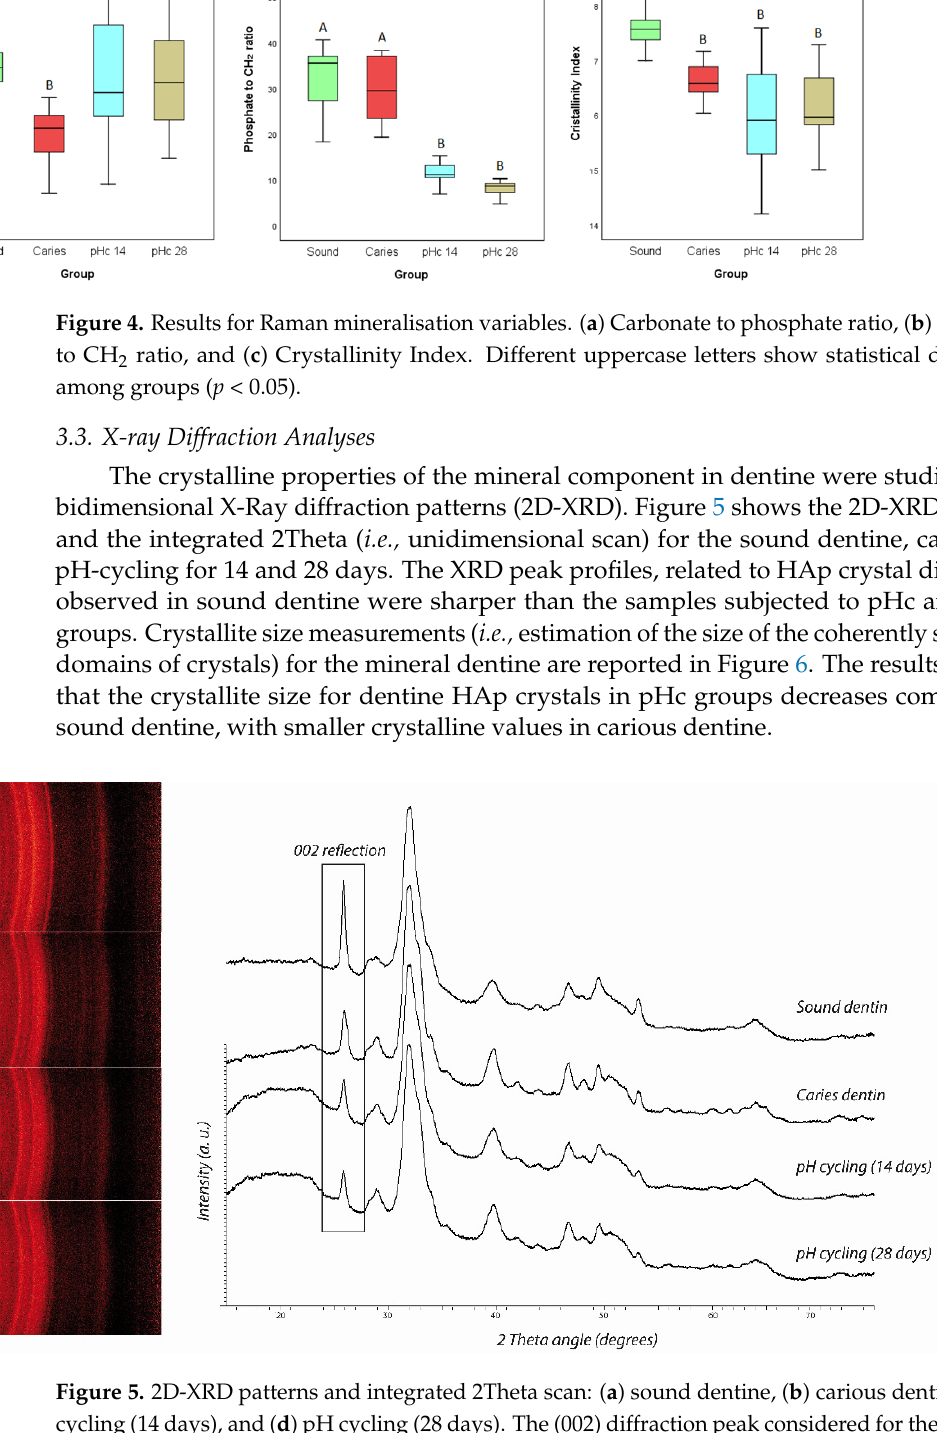
Figure 6. Results for crystallite size measurements by the integration of 2D-XRD patterns. Differ- ent uppercase letters show statistical differences among groups ( p < 0.05). Values are expressed in nanometers (nm).